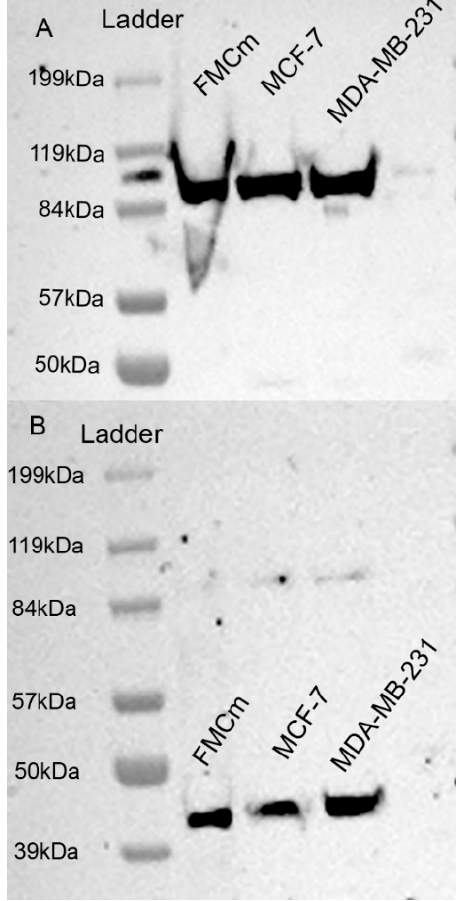
Figure 3. Western blotting analysis using antibody against TFR-1. ( A ) Western blotting analyses for cross-reactivity of the mouse anti-human TFR-1 antibody on feline proteins extracted from FMCm and human breast cancer cell lines, MCF-7 and MDA-MB-231. TFR-1 is shown as a 90 kDa protein. ( B ) Western blotting analyses for the housekeeping gene (beta-actin) on proteins extracted from FMCm, MCF-7, and MDA-MB231 cell lines. Beta-actin is shown as a 43 kDa protein.